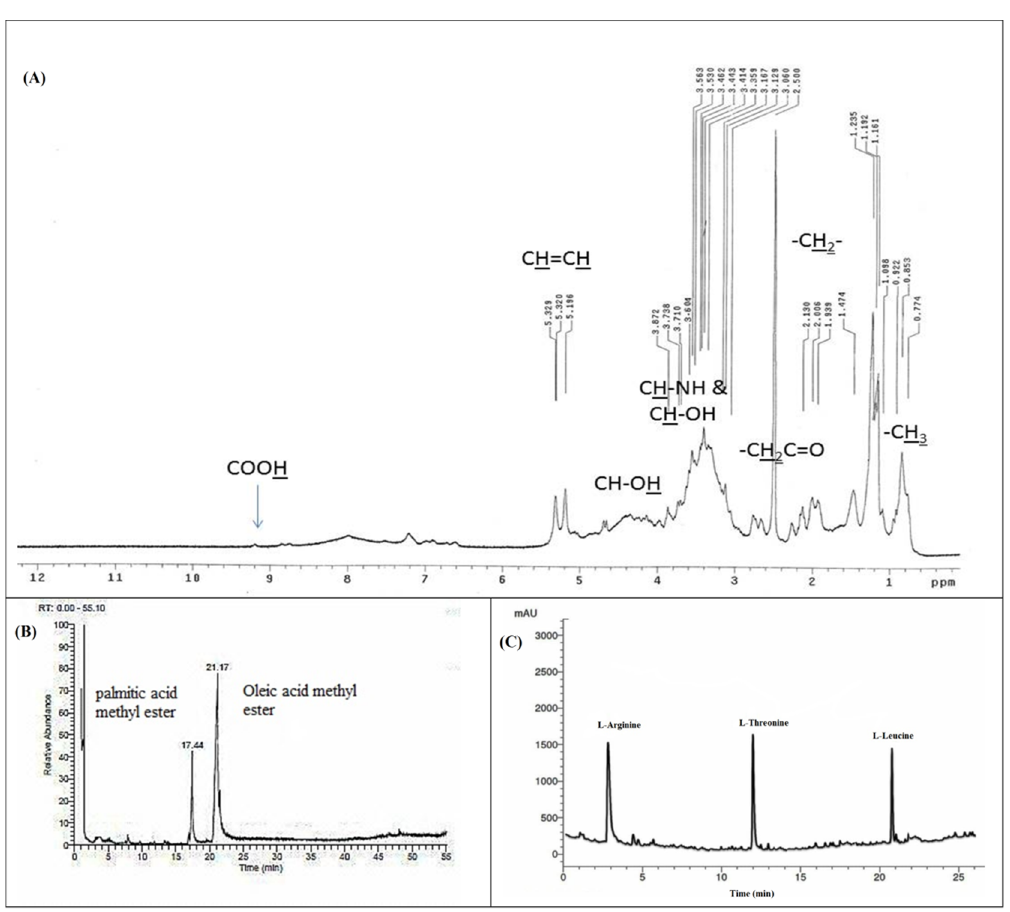
Figure 3. 1 H nuclear magnetic resonance (NMR) spectrum ( A ), GC-MS spectrum ( B ), and RP-HPLC spectrum of the Beauveria bassiana biosurfactant (BBLP) ( C ).